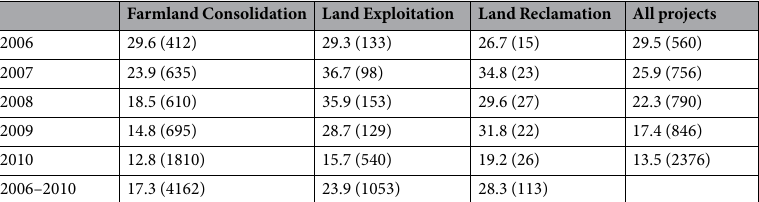
Table 1. The proportion of land consolidation project achieving effectiveness. Note: The ratio is computed by dividing the number of effective parcel by total parcel number. The number inside the brace represents the total parcel of certain